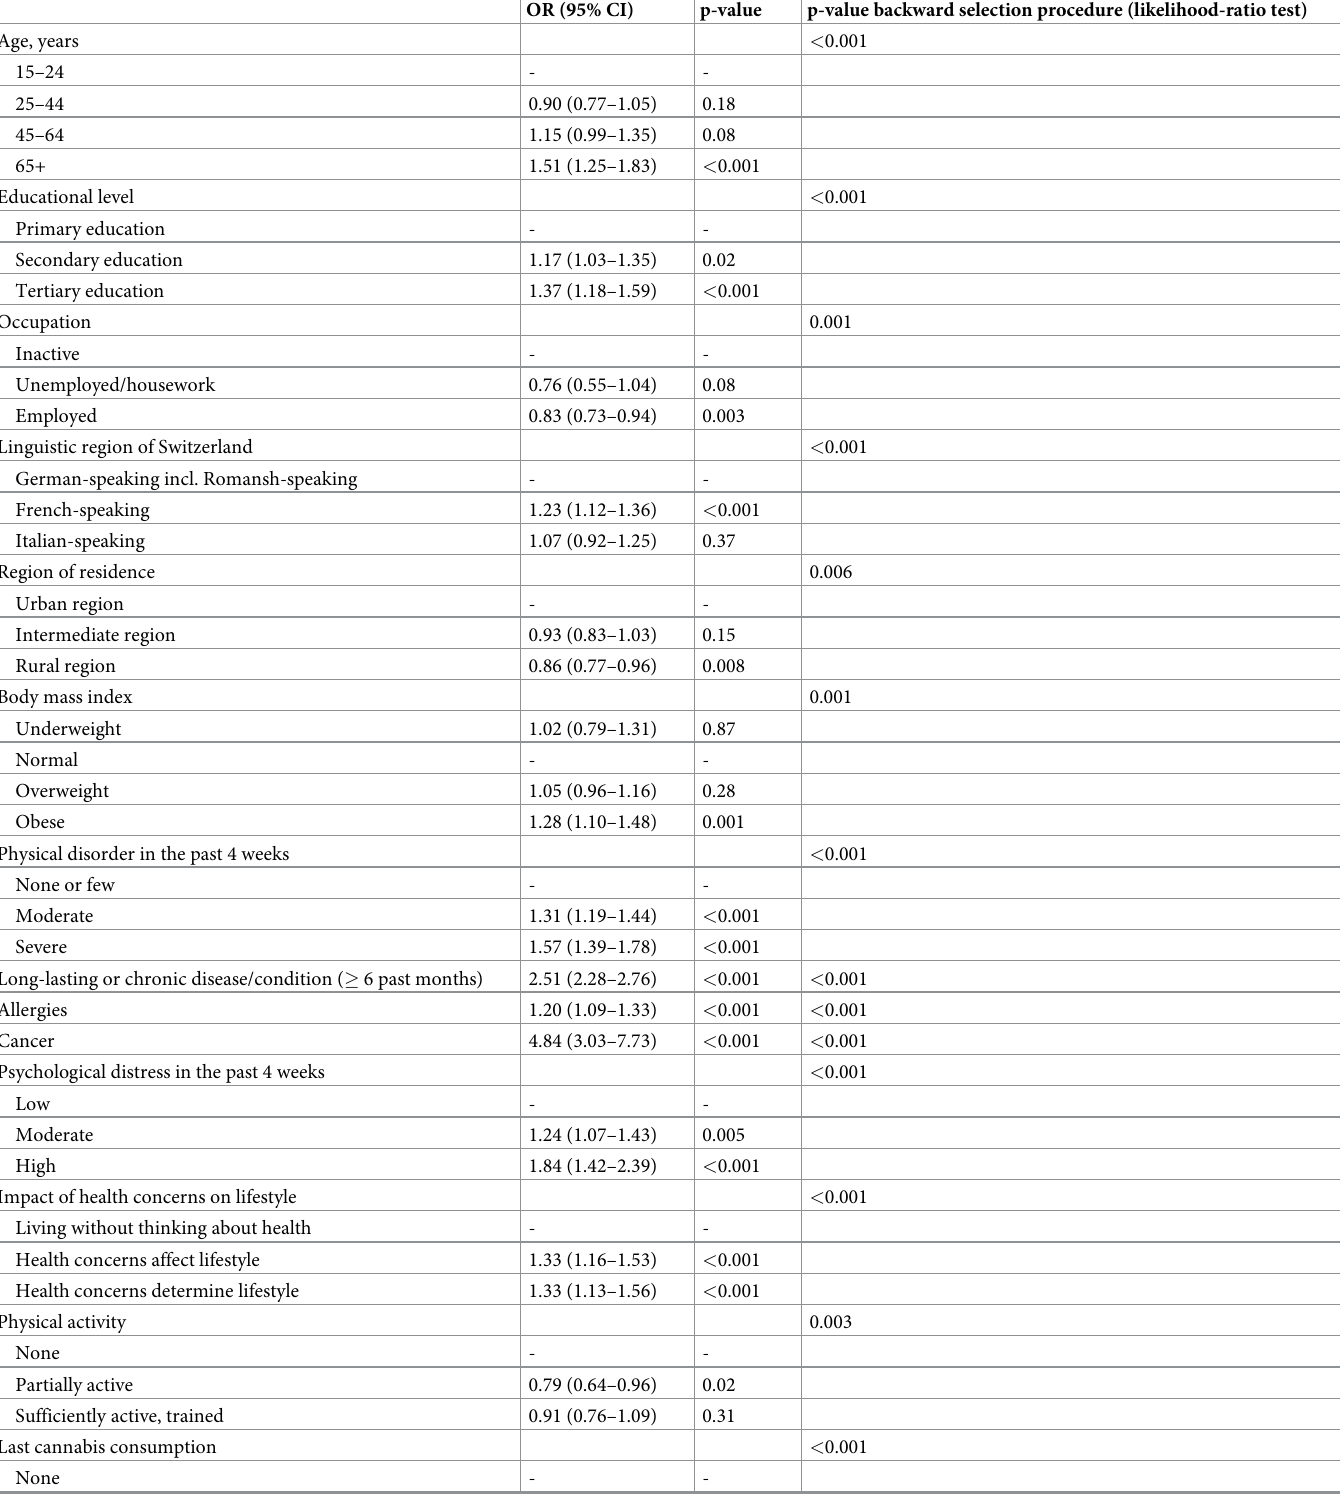
Table 10. Determinants of consultation with other medical specialists using multivariate logistic